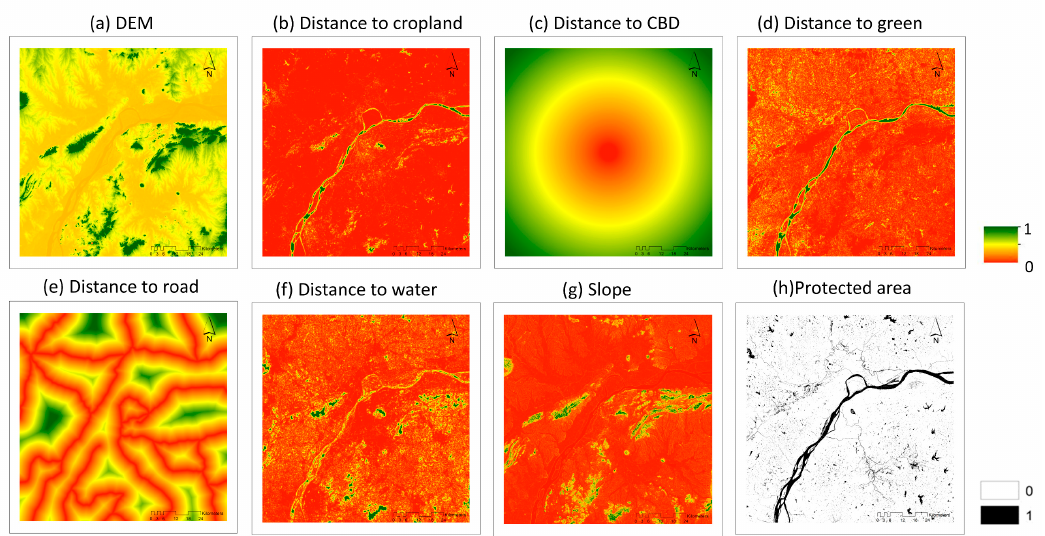
Figure A1. Modeling variables for future LULC simulation: (a) DEM; (b) distance to cropland; (c) distance to CBD; (d) distance to green; (e) distance to road; (f) distance to water; (g) slope; (h) protected area.